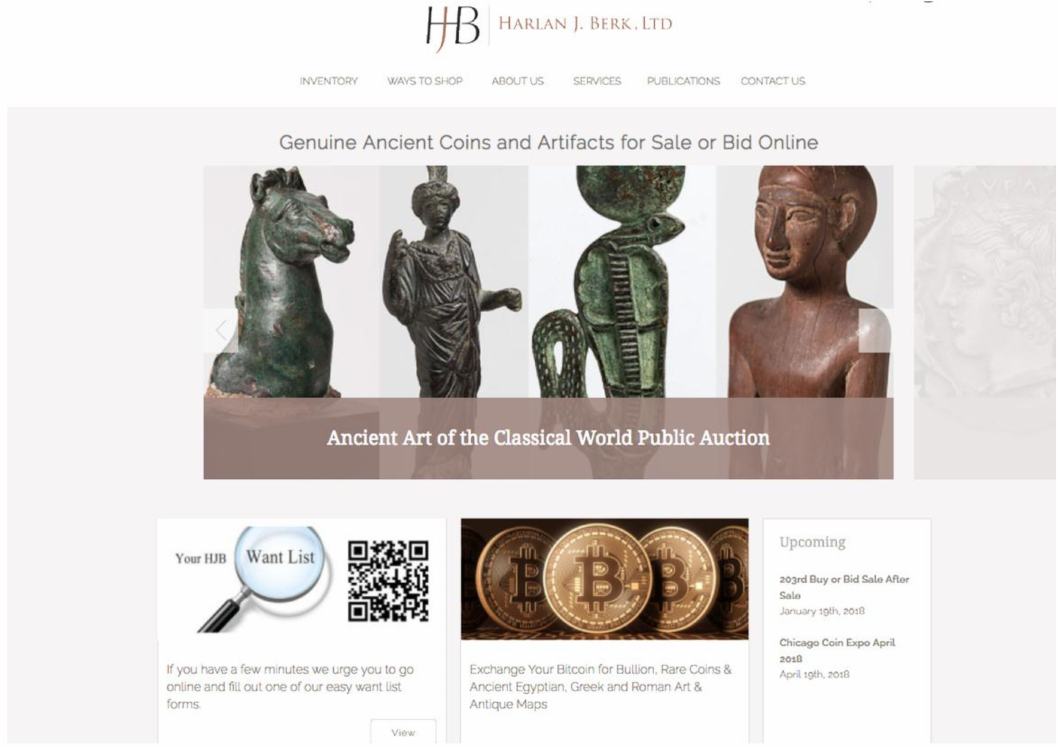
Figure 5. Screen grab taken on 11 February 2018 of the homepage for ancient coin and antiquities dealer Harlan J. Berk Ltd. in Chicago advertising Bitcoin as a newly accepted currency by the dealer. (Screen grab by author